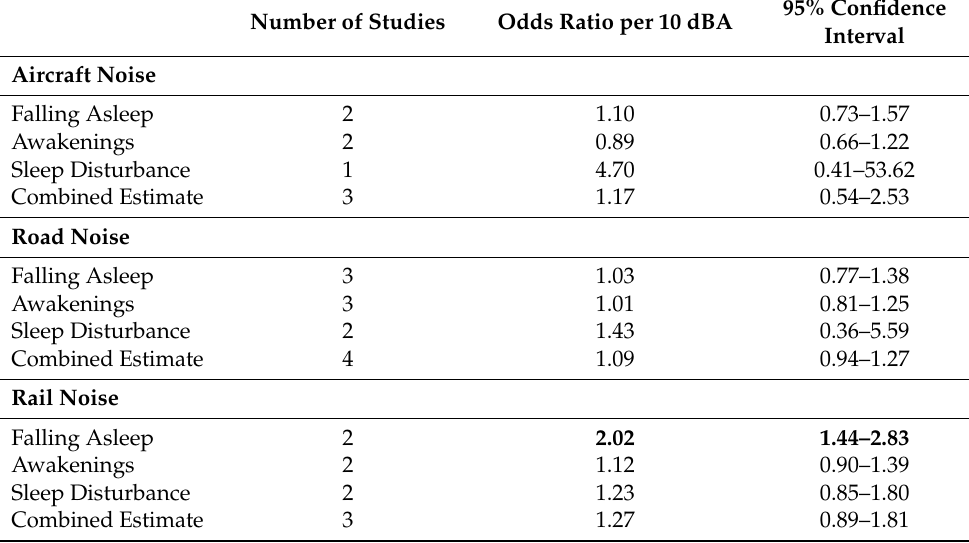
Table 6. Unadjusted Odds Ratio for the percent highly sleep disturbed for road, rail, and aircraft noise for questions on falling asleep, awakenings, and sleep disturbance for a 10 dBA increase in L night . L night was treated as a continuous variable from 40 to 65 dBA. Results are for questions that did not refer to noise in the questions. Bold font reflects statistically significant results at p < 0.05. The combined estimate is based on all sleep questions. The number of subjects contributing to the analyses can be found in Tables